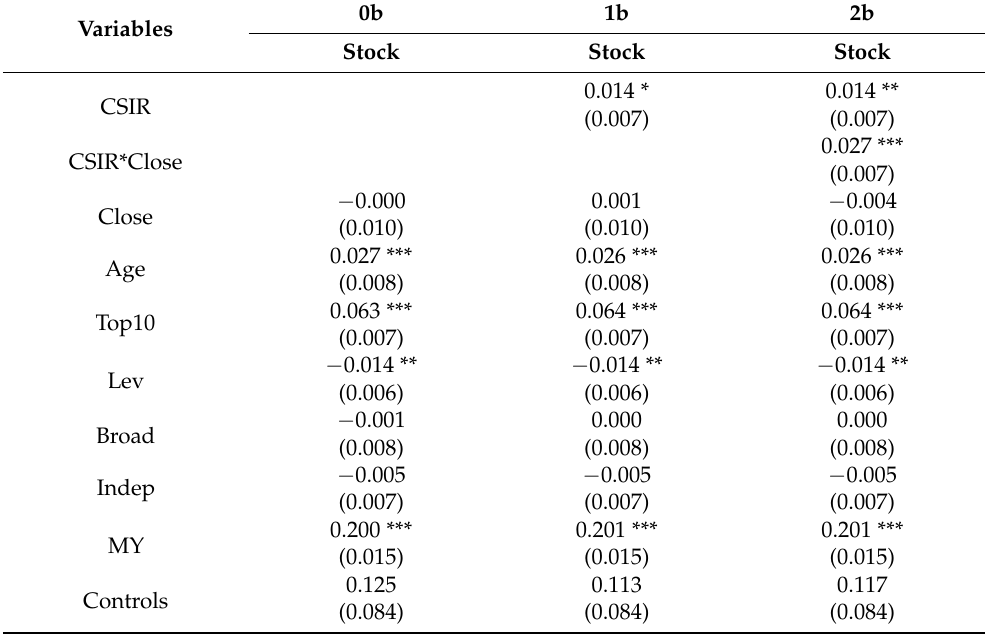
Table 4. CSR risk, social network, and capital